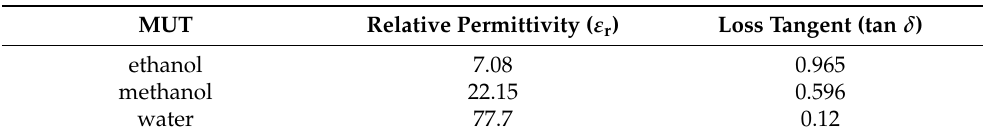
Figure 12. Effects of varying the relative permittivity of the MUT inside the liquid container on the sensitivity of the scaled radiating edge-aligned SR-CSRR-BCS slot-loaded MPA with the liquid container at the center of the top-edge: ( a ) geometry, ( b ) input reflection coefficient characteristics, ( c ) values and PRFS of the first resonant frequency when the MUT’s relative permittivity varied from 1 to 10, and ( d ) the values and PRFS of the first resonant frequency for the MUT with the relative permittivity of ethanol, methanol, and water. Table 3. Relative permittivity and loss tangent values of ethanol, methanol, and water at 2.5 GHz and 25 °C. MUT Relative Permittivity ( ε r ) Loss Tangent (tan δ )